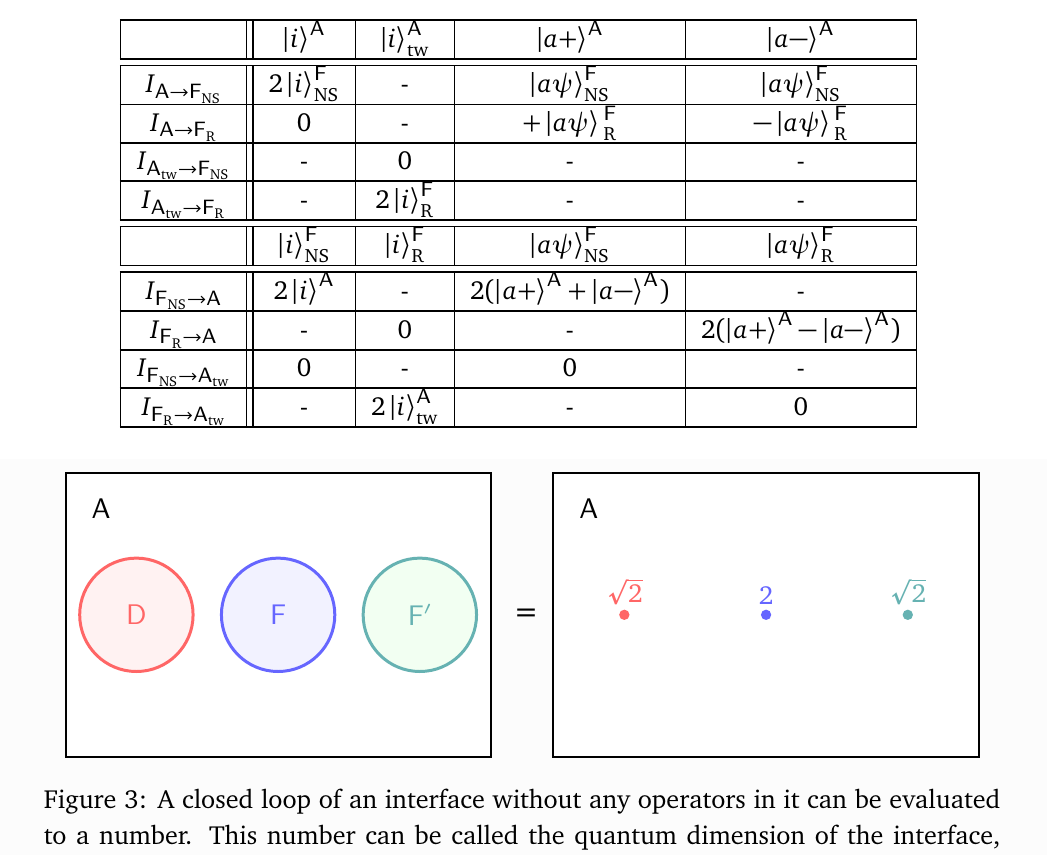
Table 3: Action of interface operators (between theories A and F ) on the boundary states.